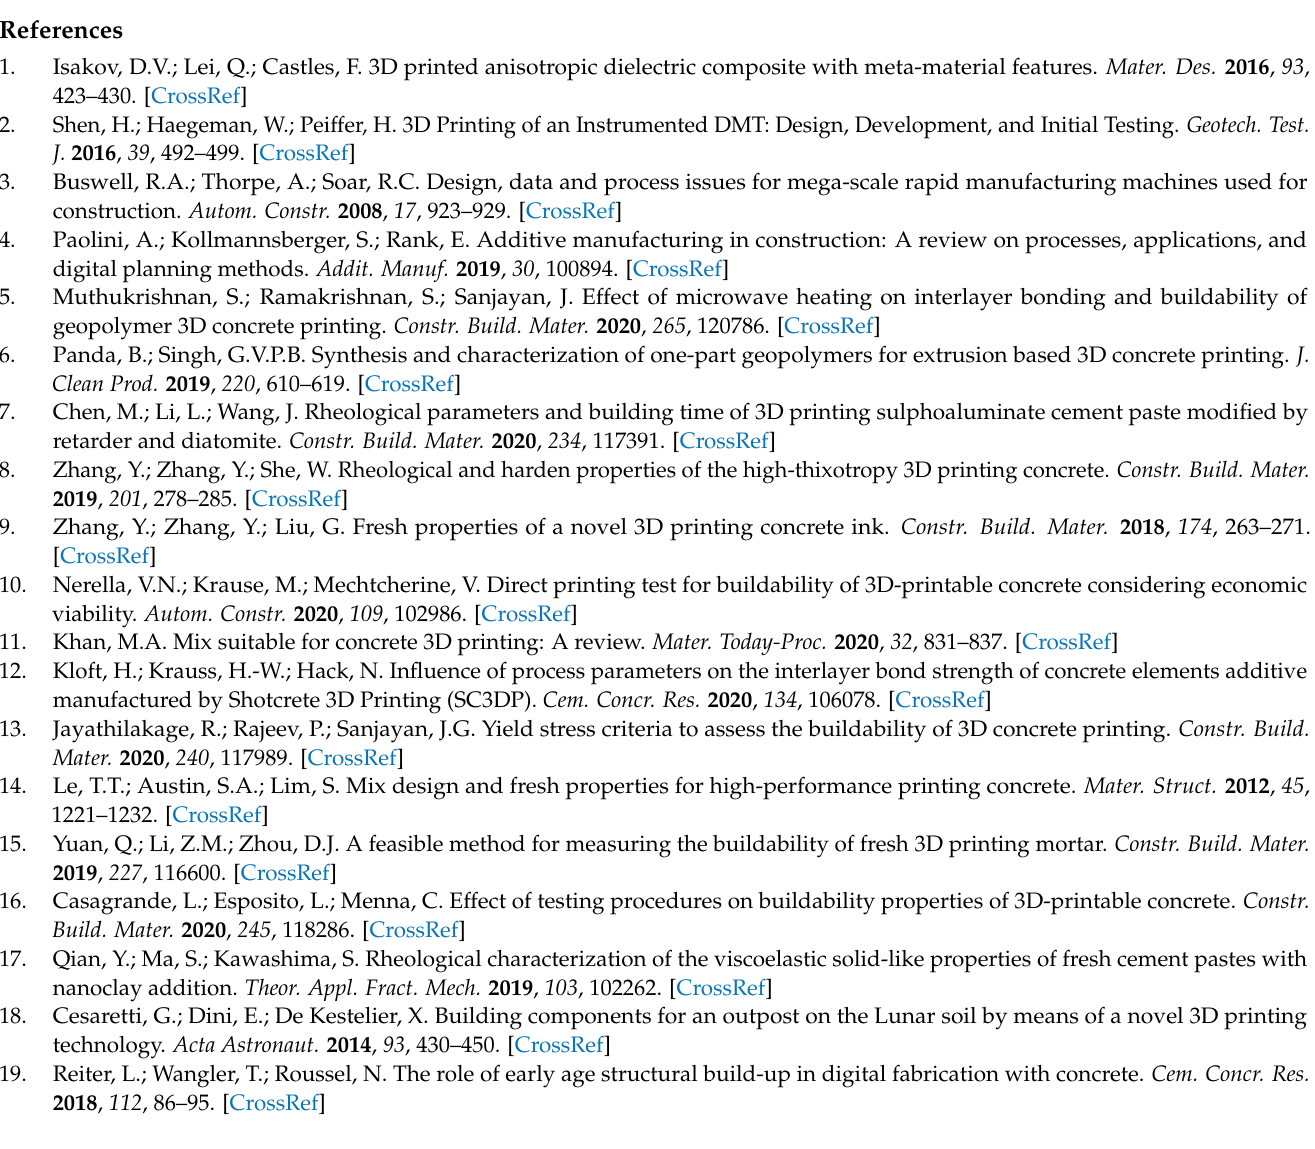
Figure A1. ( a ) The Brownian motion and van der Waals force between cement particles and action mechanism of ( b ) PCE and ( c ) TP on cement